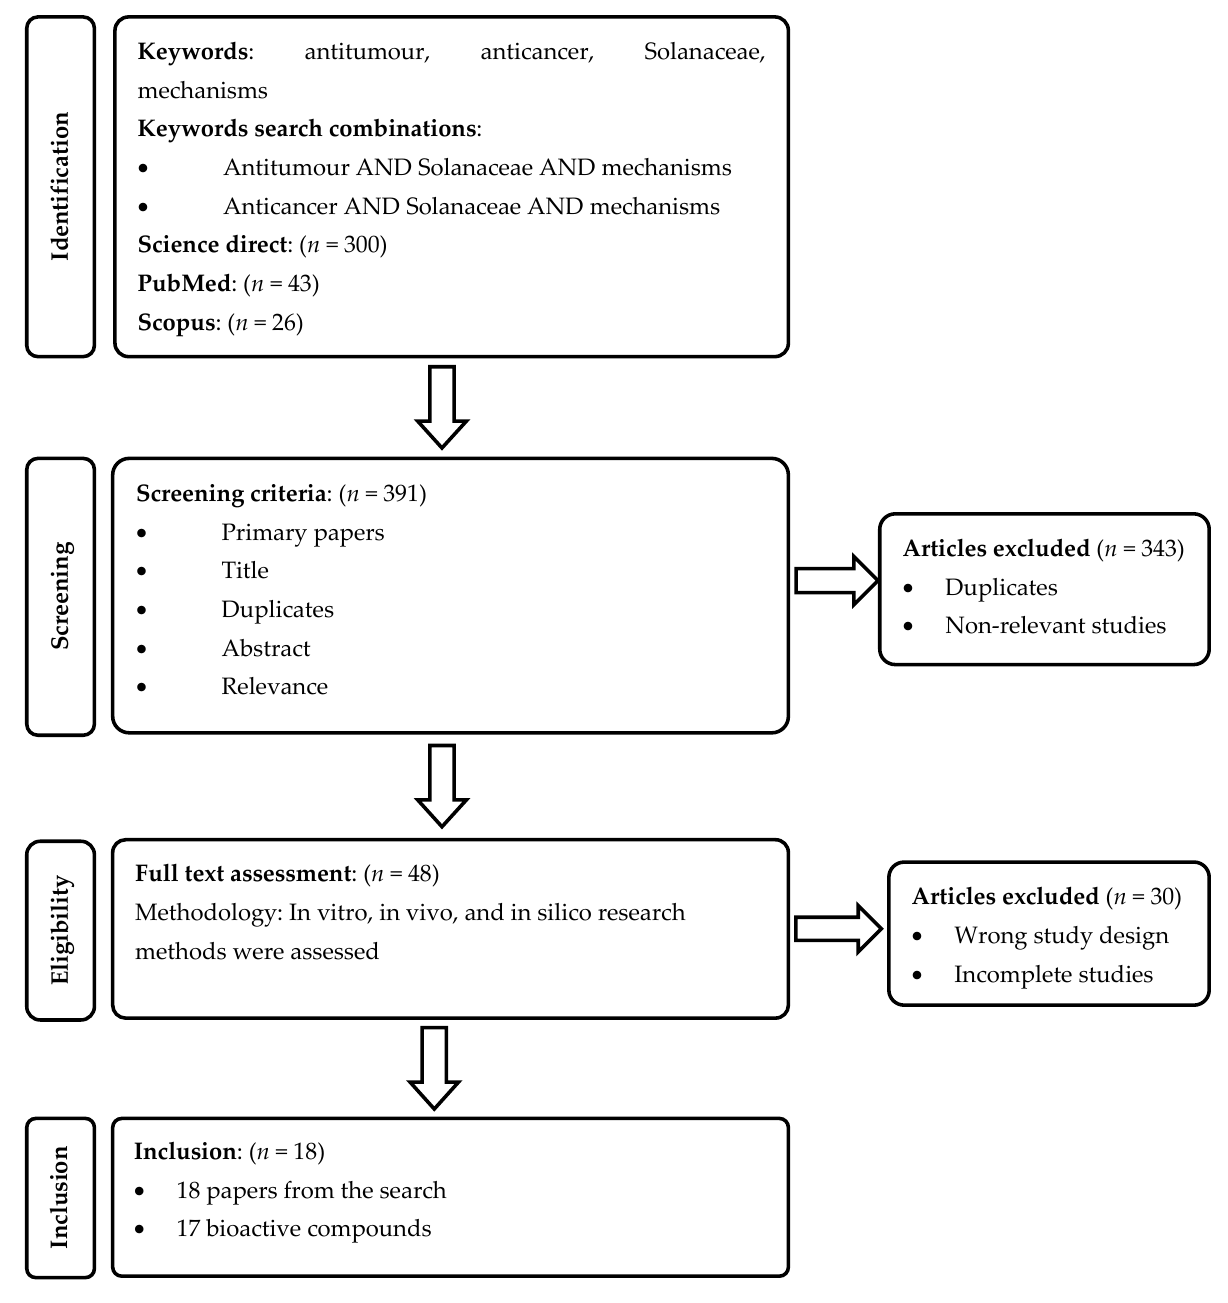
Figure 2. Flow chart summarising the literature search. n represents the number of articles.